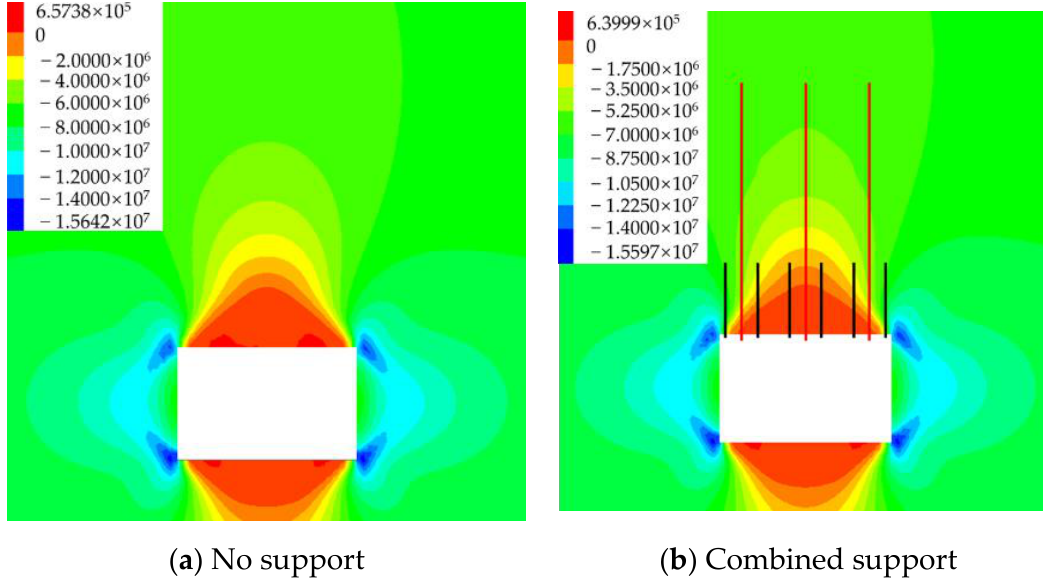
Figure 19. Vertical stress distribution of the roadway with and without support.